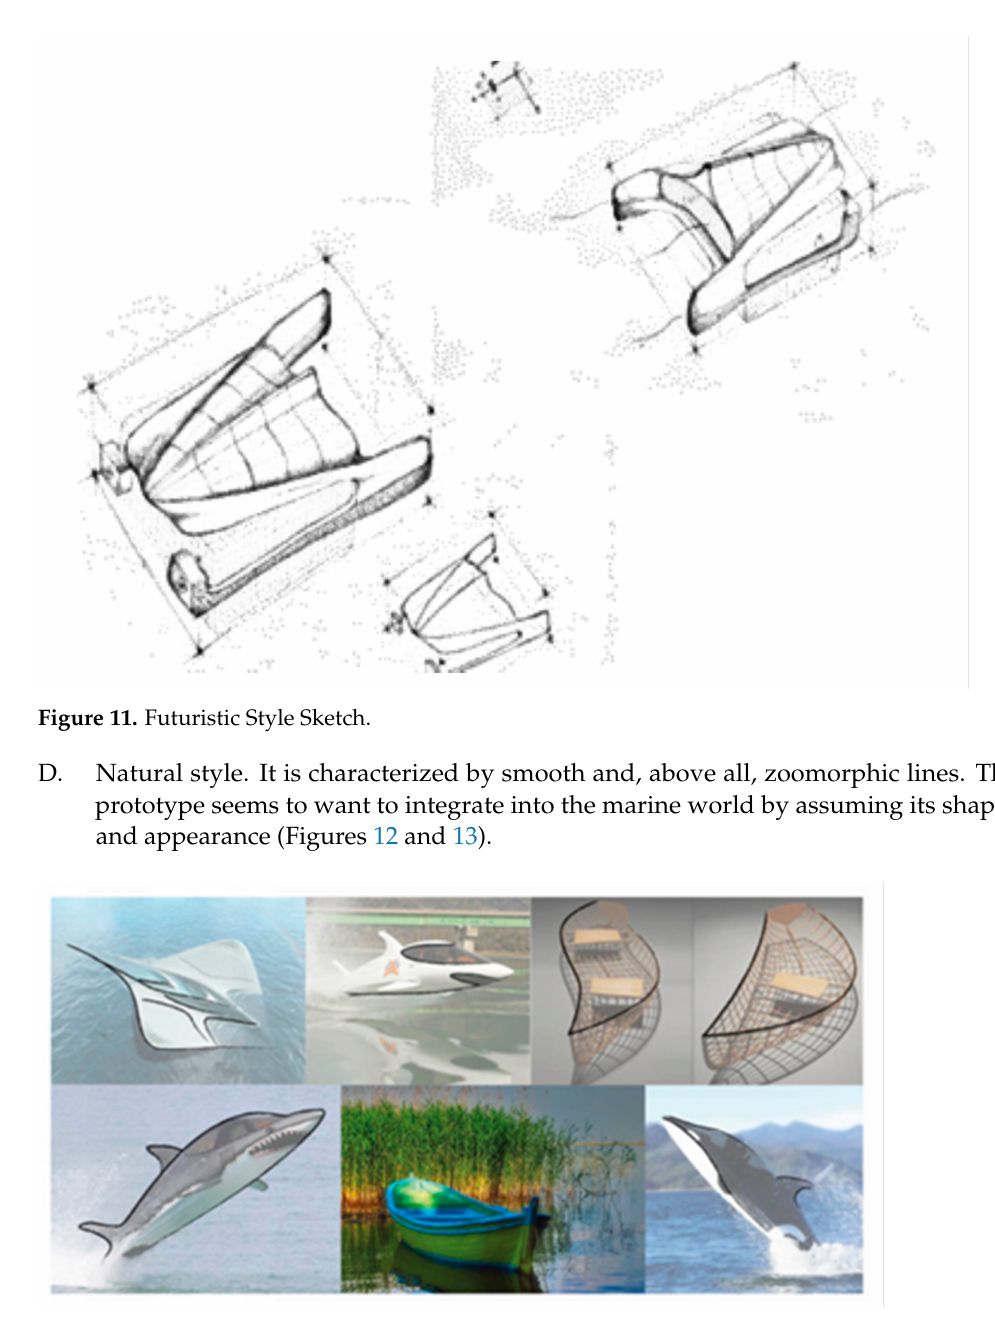
Figure 12. Natural Style